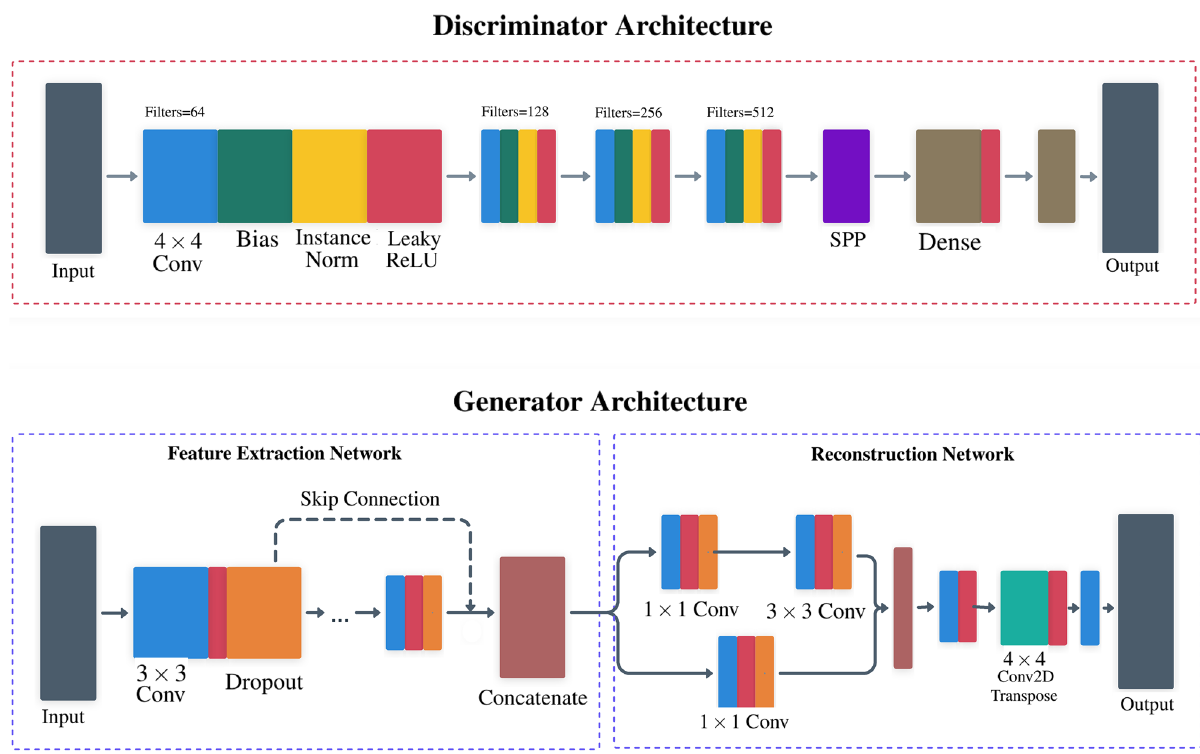
Figure 2. The discriminator and generator architectures devised for GAN-SR of medical